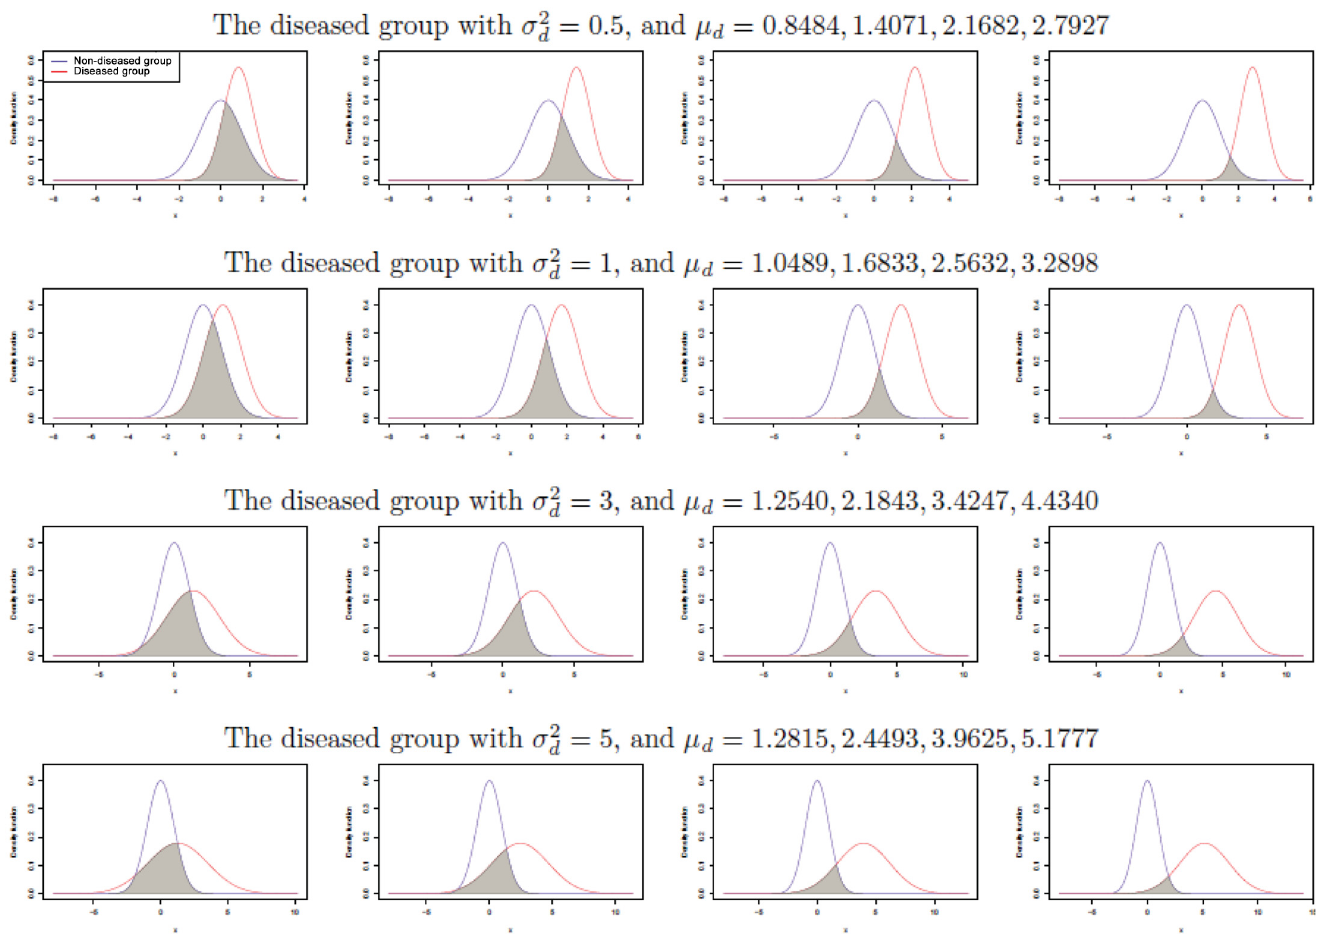
Fig 1. Density functions for a non-diseased group (a standard normal distribution) and a diseased group when the data is generated from two normal distributions as in Table 1.